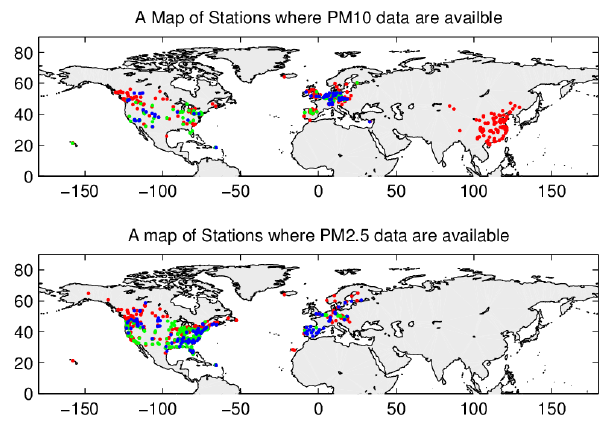
Figure 1. (Top panel) A map of stations over China, Europe, U.S., and Canada Fig. 1. (Top panel) A map of stations over China, Europe, US, and (red points: urban sites, green points: suburban sites, and blue points: rural sites). Canada (red points: urban sites, green points: suburban sites, and Europe and U.S. stations have more than 120 months of data of PM10 during the blue points: rural sites). Europe and US stations have more than study period, while China and Canada stations have more than 60 months of data 120 months of data of PM 10 during the study period, while China of PM10 available during the study period. (Bottom panel) A map of stations over and Canada stations have more than 60 months of data of PM 10 Europe, the U.S., and Canada (red points: urban sites, green points: suburban available during the study period. (Bottom panel) A map of stations sites, and blue points: rural sites) where PM2.5 data are available for more than 60 over Europe, the US, and Canada (red points: urban sites, green months from 1998 to 2010. points: suburban sites, and blue points: rural sites) where PM 2 . 5 data are available for more than 60 months from 1998 to